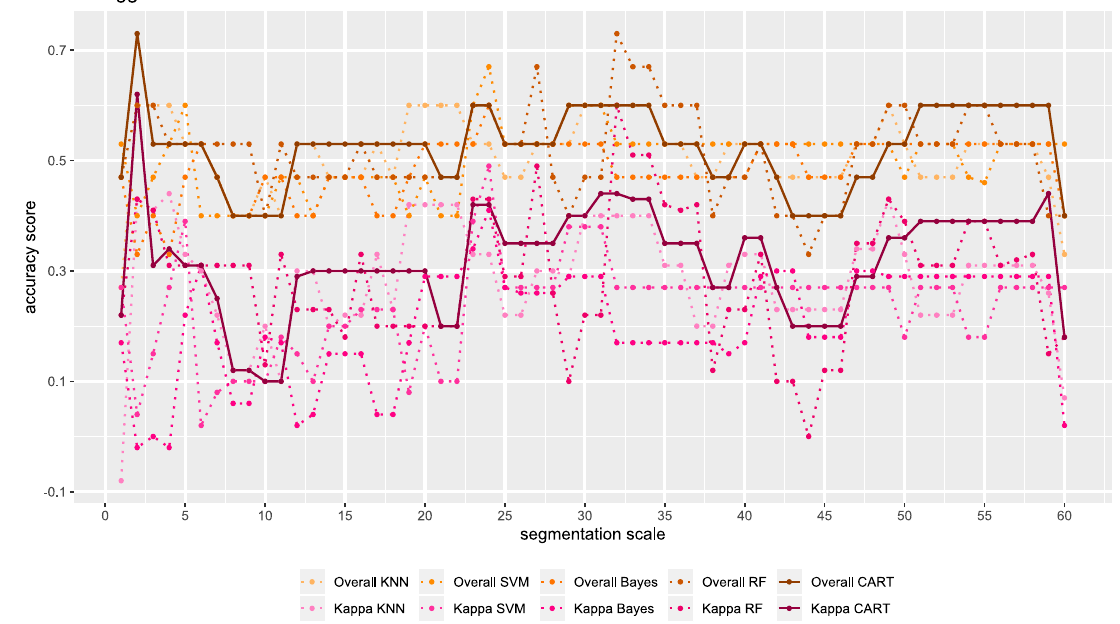
Figure A4. Overall and kappa accuracy assessment charts for scales of multiresolution segmentation 1–60. Chioggia 2016 dataset divided for four classes, Boruta feature-selection algorithm.